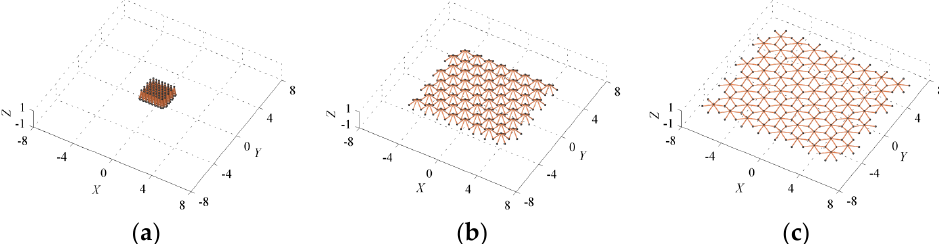
Figure 6. Motion of a deployable structure assembled by 8 8 × basic units, with n 1 = 3 and n 2 = 6: ( a ) Folded configuration; ( b ) partially deployed configuration; ( c ) deployed configuration.